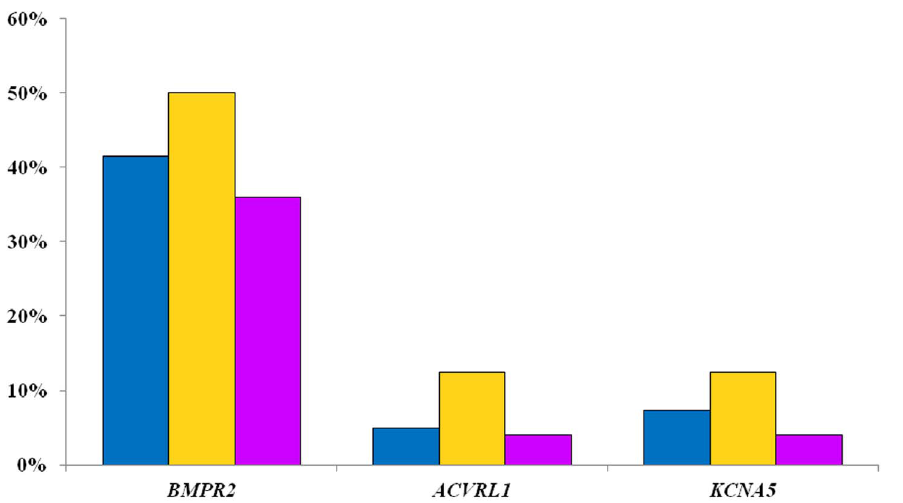
Figure 2. Frequency of pathological mutations found in our patients (blue all patients, yellow IPAH, purple APAH). BMPR2 showed the greatest number of mutations.